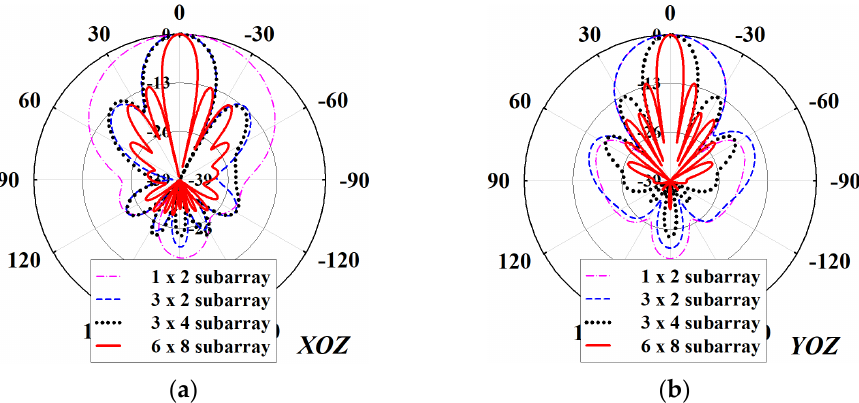
Figure 5. Simulated radiation patterns at 9.65 GHz for all of the subarrays of the proposed antenna: ( a ) XOZ-plane, and ( b ) YOZ-plane.